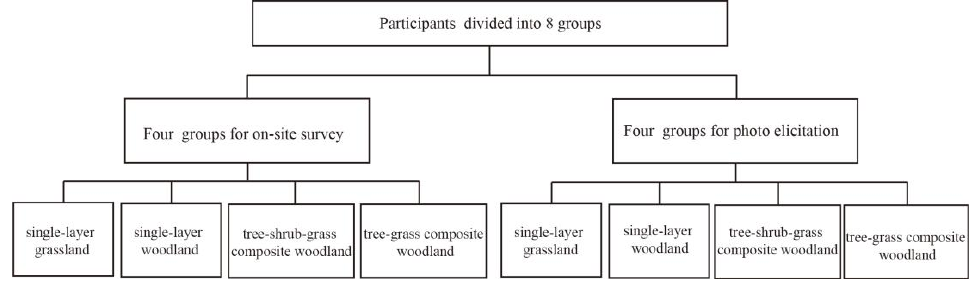
Figure 2. The hierarchical arrangement of participation groups.